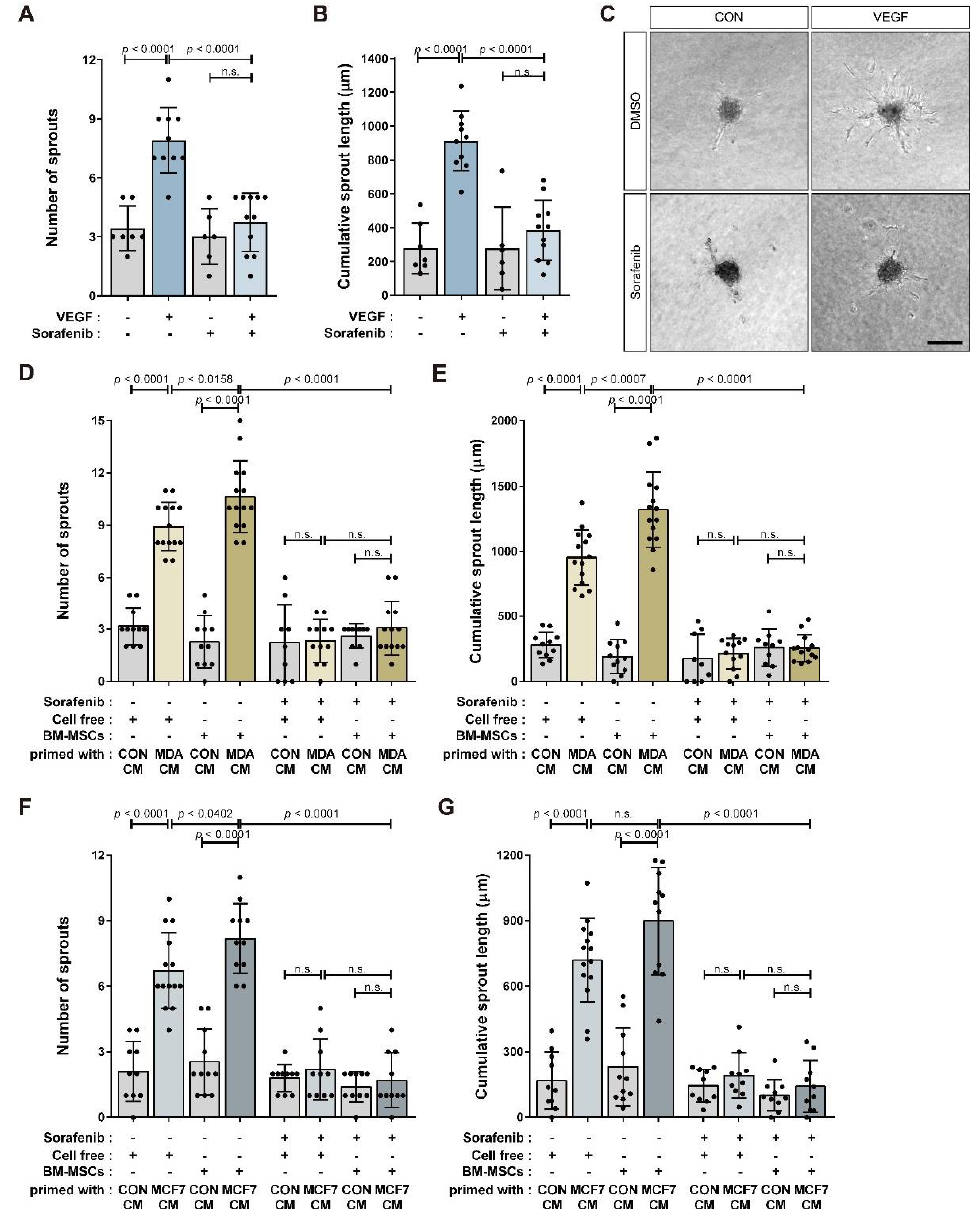
Figure 5. VEGF signaling-mediated promotion of angiogenic activity in HUVECs incubated with conditioned media from BM-MSCs primed with breast tumor-mimicking conditions: ( A – C ) VEGF increased the sprouting of HUVEC spheroids, while sorafenib (5 μM) pretreatment inhibited the increase; representative images of each experimental condition ( C ). ( D – G ) Sorafenib pretreatment suppressed the sprouting capacity of HUVEC spheroids that increased in response to conditioned media from BM-MSCs primed with CON CM, MDA CM, or MCF7 CM. Results are presented as the mean ± SD. Scale bar = 100 μm.